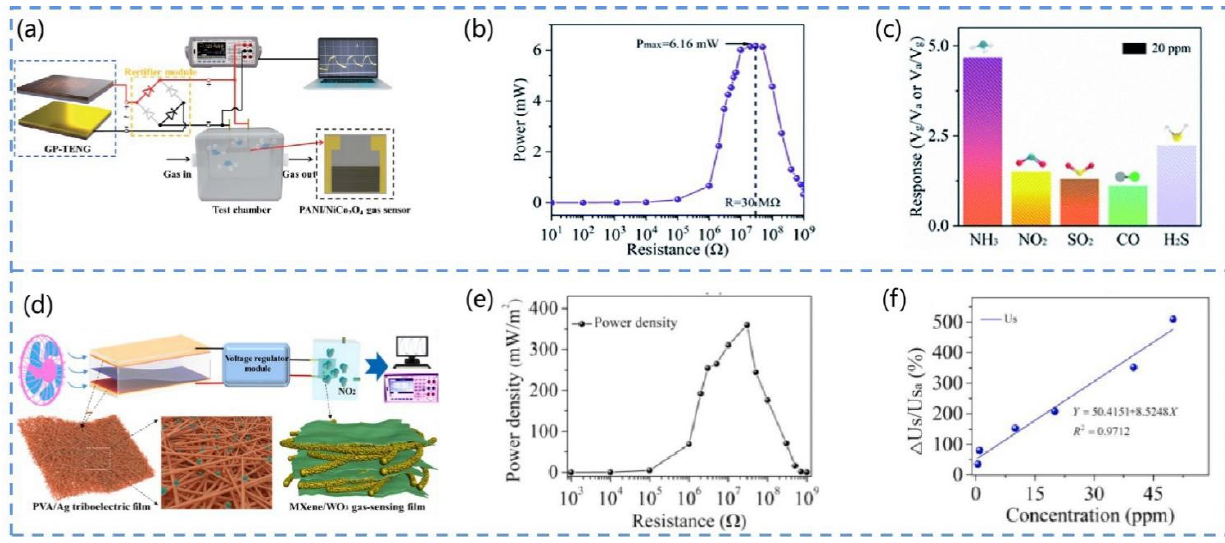
Figure 8. ( a ) Schematic diagram of the self-powered ammonia sensing system (GPAS). ( b ) Schematic diagram of the output power of the GP-TENG. ( c ) Results of the GPAS responsiveness test to ammonia gas. Reprinted from [64] with permission from the Royal Society of Chemistry. ( d ) Schematic diagram of the self-powered nitrogen dioxide gas sensor. ( e ) Output power density of the TENG. ( f ) Voltage response of the sensing system to nitrogen dioxide. Reprinted from [65] with permission from